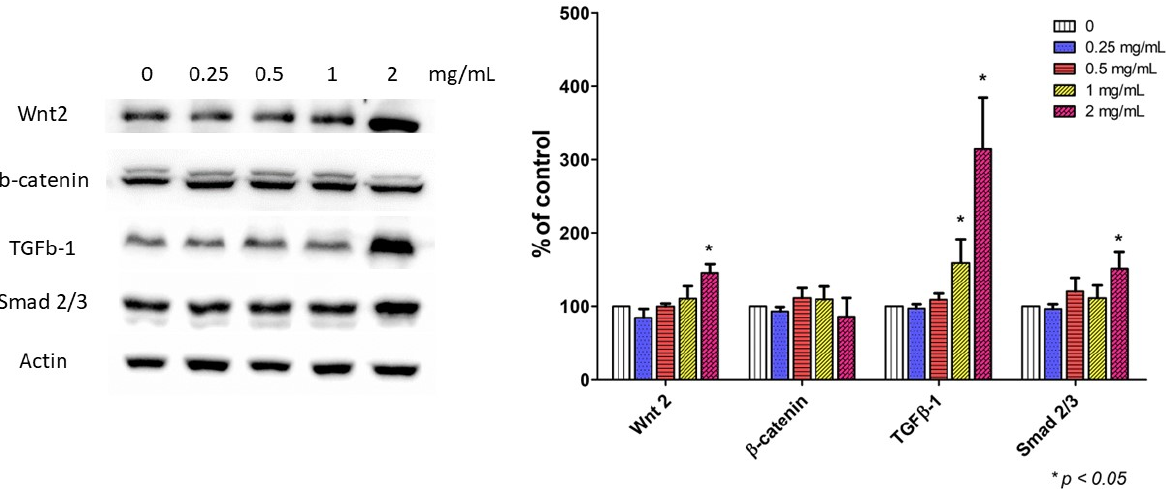
Figure 7. The results of western blot. Left : an image of the western blot. As the dose of NF3 increased (0.25–2 mg/mL), the expressions of Wnt 2, TGF β -1, and Smad 2/3 increased. Right : the quantitative result. Compared with the control, the expressions of Wnt 2, TGF β -1, and Smad 2/3 increased significantly after NF3 treatment ( p < 0.05).